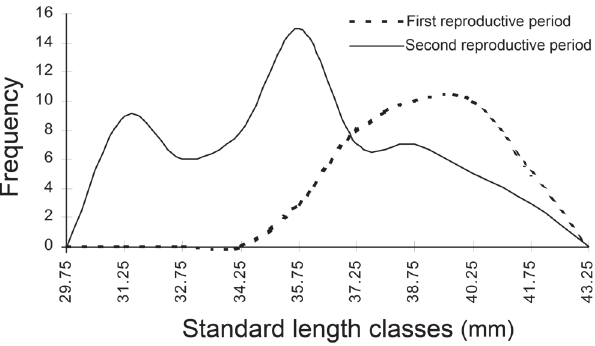
Fig. 6. Distribution of the absolute frequencies of the standard lengths of females of Odontostilbe pequira in the first (September/October) and second (January/February) reproductive